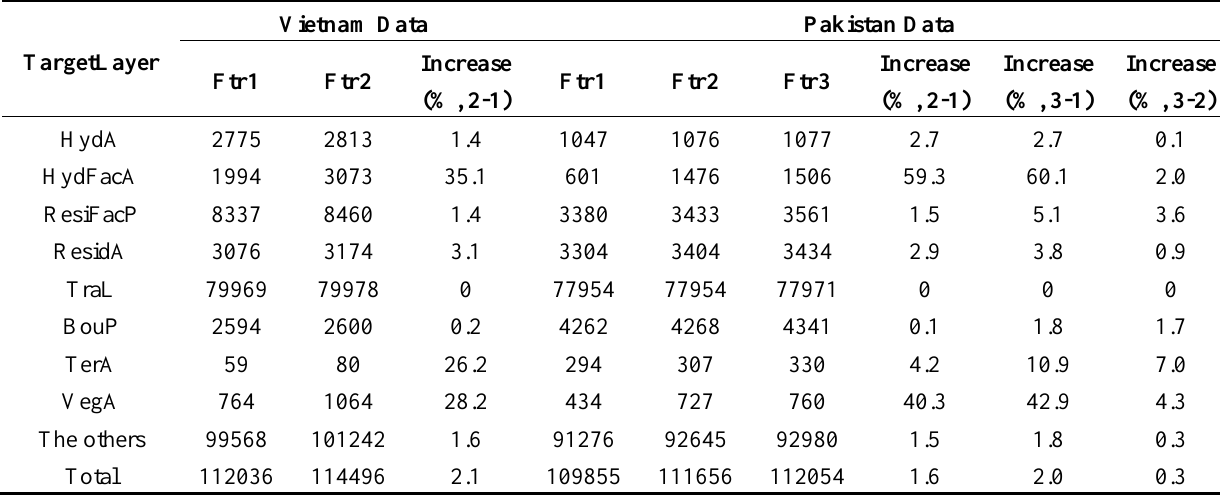
Table 2. Features converted by different rule set.